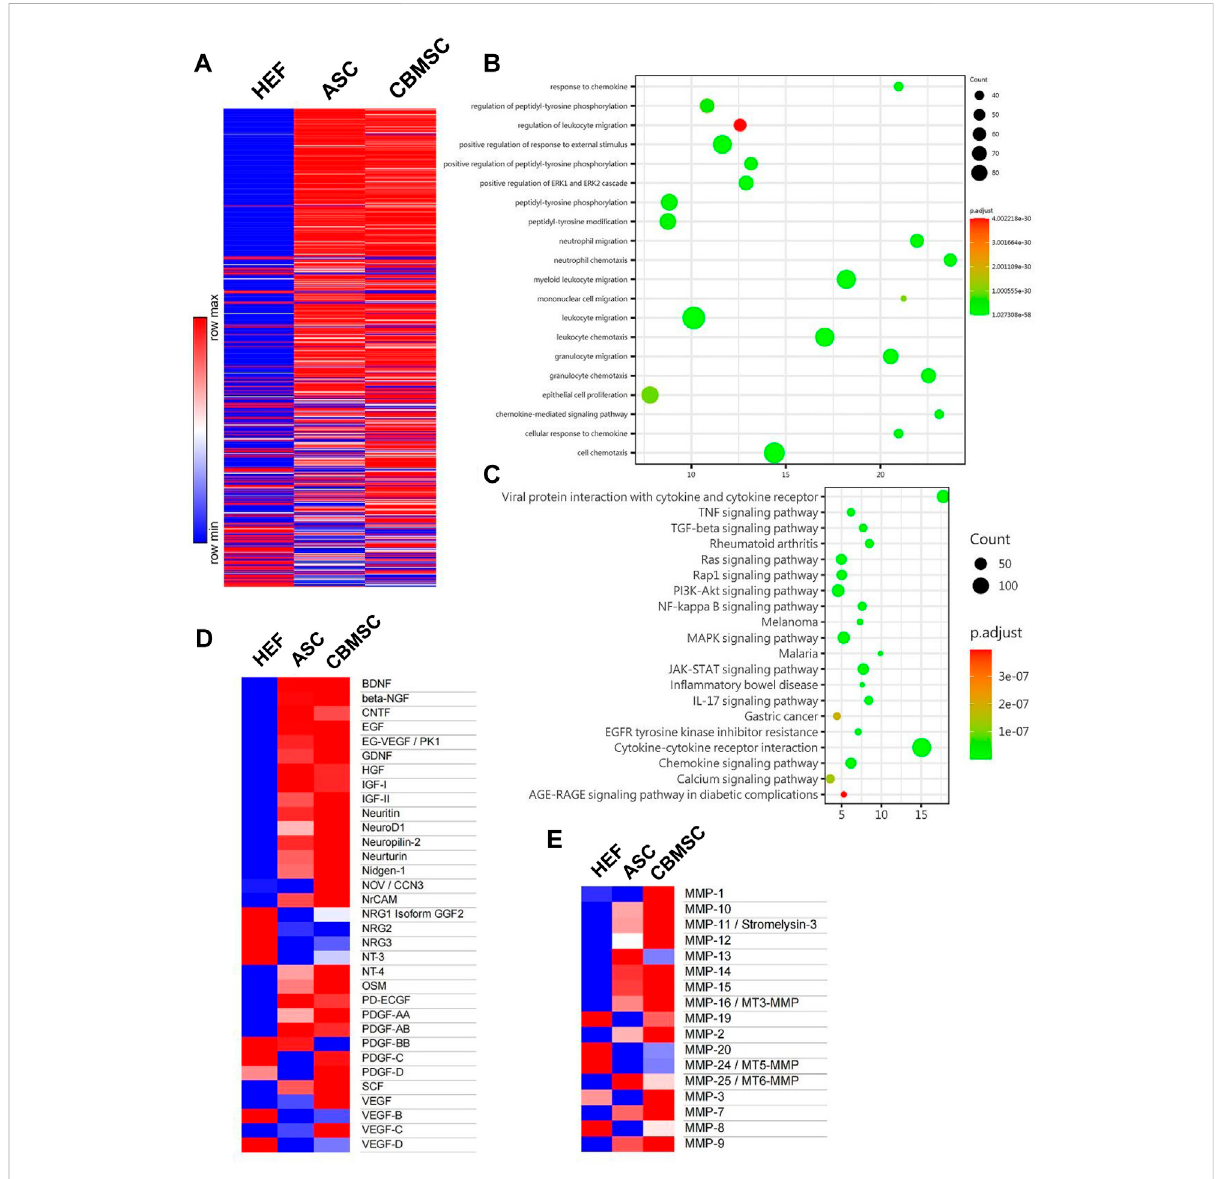
FIGURE 6 Soluble factors secreted by CBMSCs and ASCs in the conditioned medium were analyzed using protein chips. (A) Relative concentration of 507 proteins in HEF-CM, ASC-CM, and CBMSC-CM is shown in a heat map. (B) Gene Ontology (GO) function enrichment analysis of biological processes of CBMSC-CM vs. ASC-CM. (C) KEGG signaling pathway enrichment analysis of CBMSC-CM vs. ASC-CM. Heat map of differentially expressed neurotrophic factors (D) and matrix metalloproteinases (E) in CBMSC-CM vs. ASC-CM. See also Supplementary Tables S1 – S3. hEF, CBMSC, and ASC represent the CMs of these